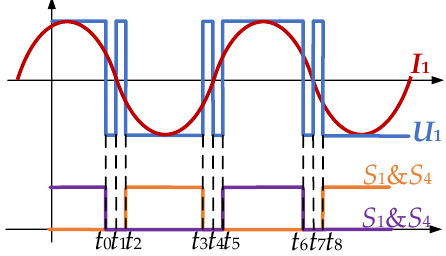
Figure 4. Waveforms of U 1 & I 1 and gate signals of the inverter in a full switching cycle with f d = f r .